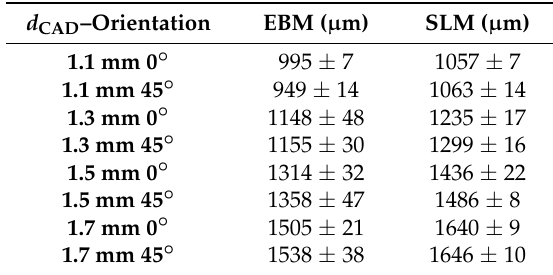
Table 4. Results from determinations of the equivalent diameter ( n = 10 for each part).